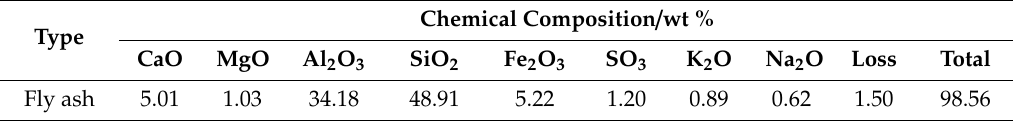
Table 2. Chemical composition of fly ash.